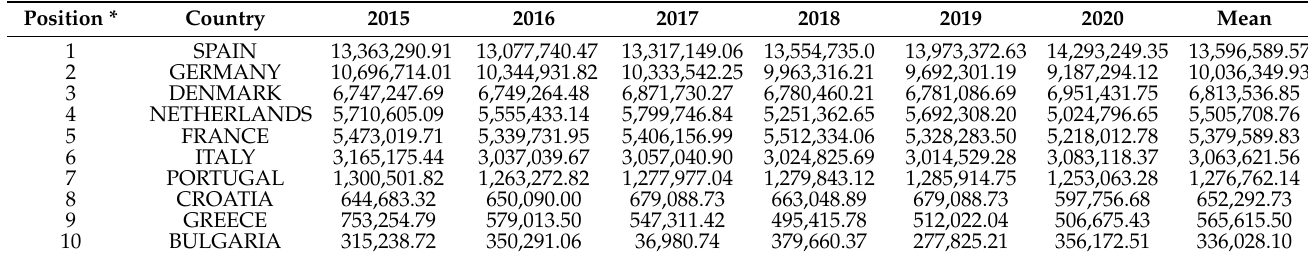
Table 4. Results of CH 4 emissions from manure management using Tier 1 methodology (Gg CO 2 - eq/year).